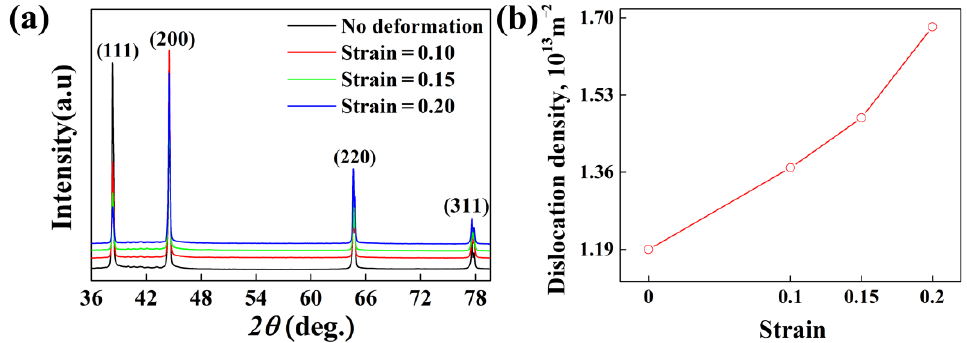
Figure 11. ( a ) XRD patterns; ( b ) the dislocation density of alloy samples with different strains after aging at 120 °C for 28 h.